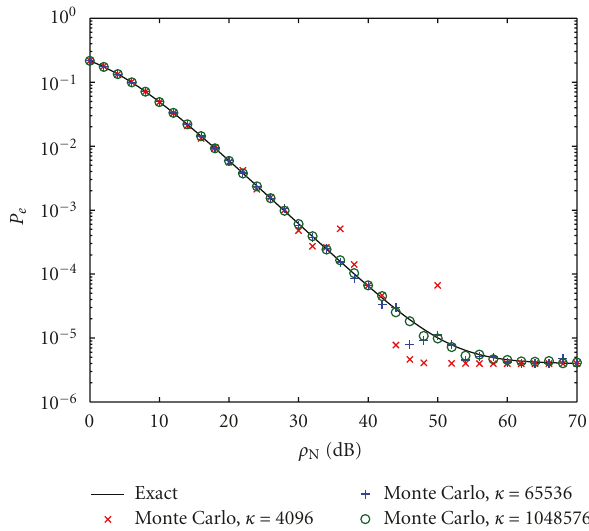
Figure 6: Approximation by Monte Carlo integration ( ρ I = 13